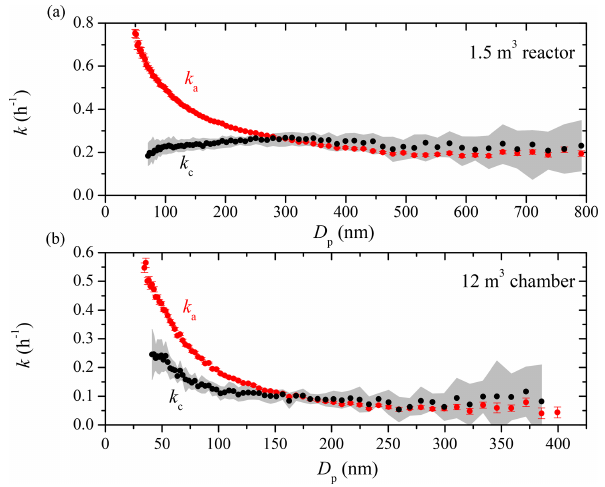
Figure 1. The apparent (red symbols) and coagulation-corrected (black symbols) particle wall-loss rate constants as a function of particle size for (a) the 1.5m 3 Teflon reactor and (b) the 12m 3 CMU smog chamber after the two systems have been left undis- turbed in the lab for weeks. The particle loss rate constants were derived based on SMPS measurements from Exp. 1 and 2. Only k a values with an R 2 > 0 . 5 are shown. The error bars correspond to 1 standard deviation. The grey area is the uncertainty associated with k c .